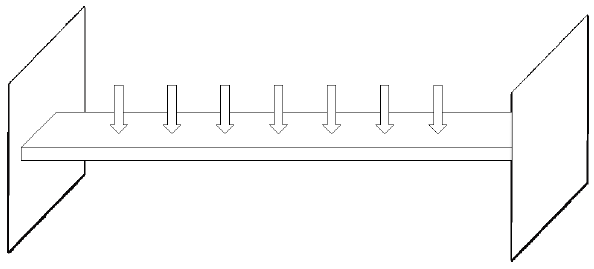
Figure 6: A single shell under uniform transverse